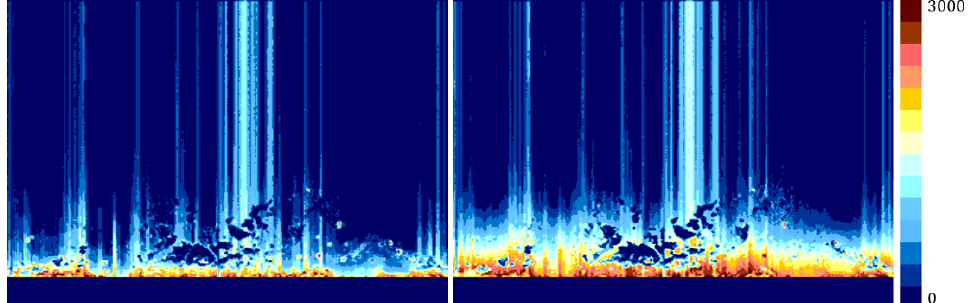
Figure 7. Numbers of non-meteorological echoes detected separately by algorithms from the left: DP.TURBINE and DP.NMET. Ram˙za radar, September 2018, the lowest elevation. Up to 25km from the radar, the algorithm is not applied.